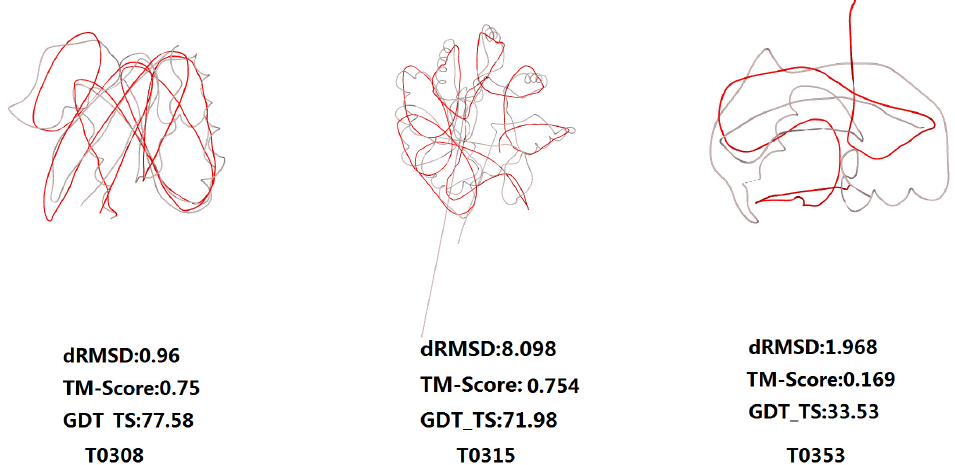
Figure 15. Visualization of the three-level structure of T0308, T0315, and T0353. Red is the predicted structure, gray is the real structure.